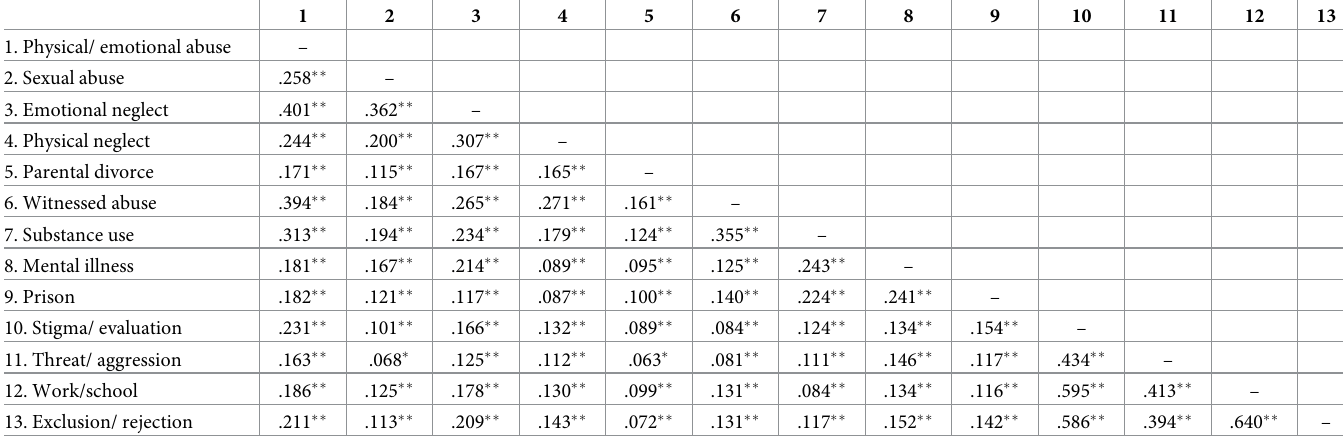
Table 3. Bivariate correlations of ACEs and perceived discrimination indicators for Mexicans.